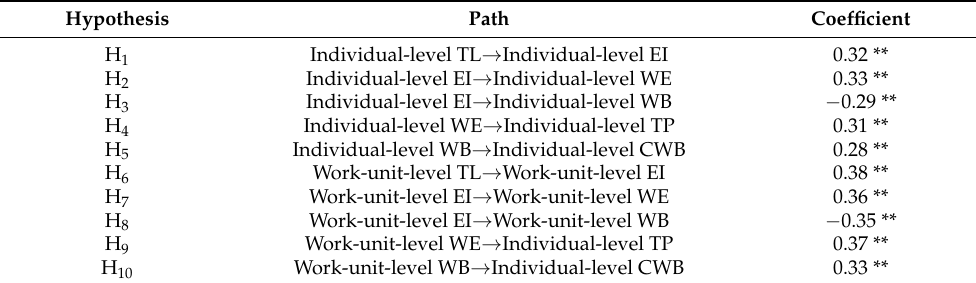
Table 2. The Results of